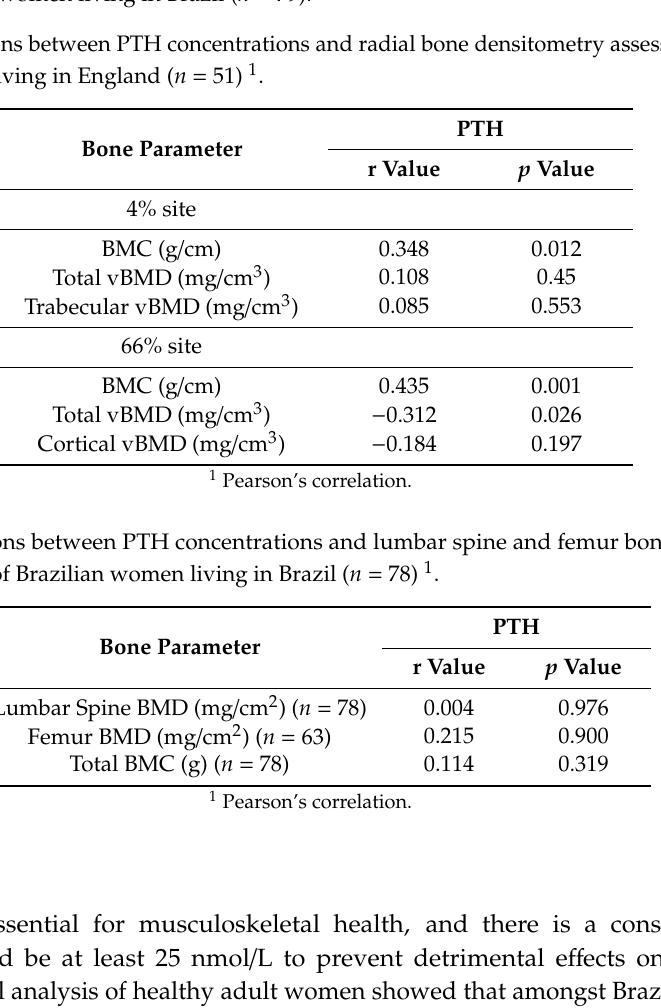
Table 9. Correlations between PTH concentrations and lumbar spine and femur bone densitometry assessed by DXA of Brazilian women living in Brazil ( n = 78) 1 .